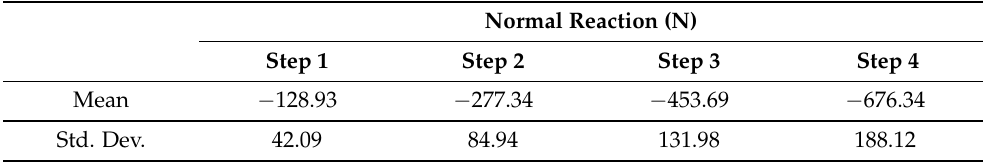
Table 7. Statistical analysis of variation in difference of normal reaction at the rear wheel during the controlled and uncontrolled conditions with respect to center of gravity of